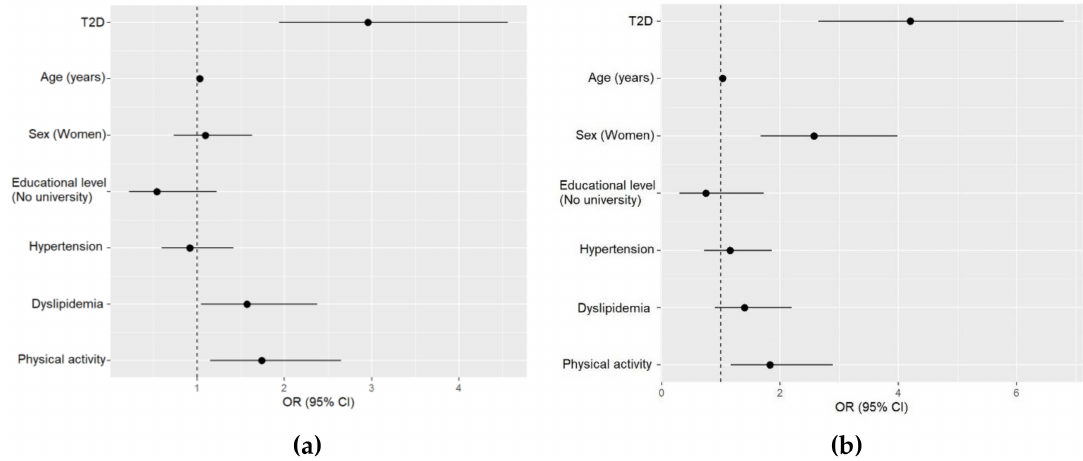
Figure 1. Multivariable analyses for the alternate Mediterranean Diet (aMED) score and alternate Healthy Eating Index (aHEI), including all the study groups. ( a ) Multivariable logistic regression for the aMED high tertile (6–9 points). Hosmer–Lemeshow test p < 0.001; ( b ) multivariable logistic regression for the aHEI high tertile ( ≥ 46 points). Hosmer–Lemeshow test p < 0.001. T2D, type 2